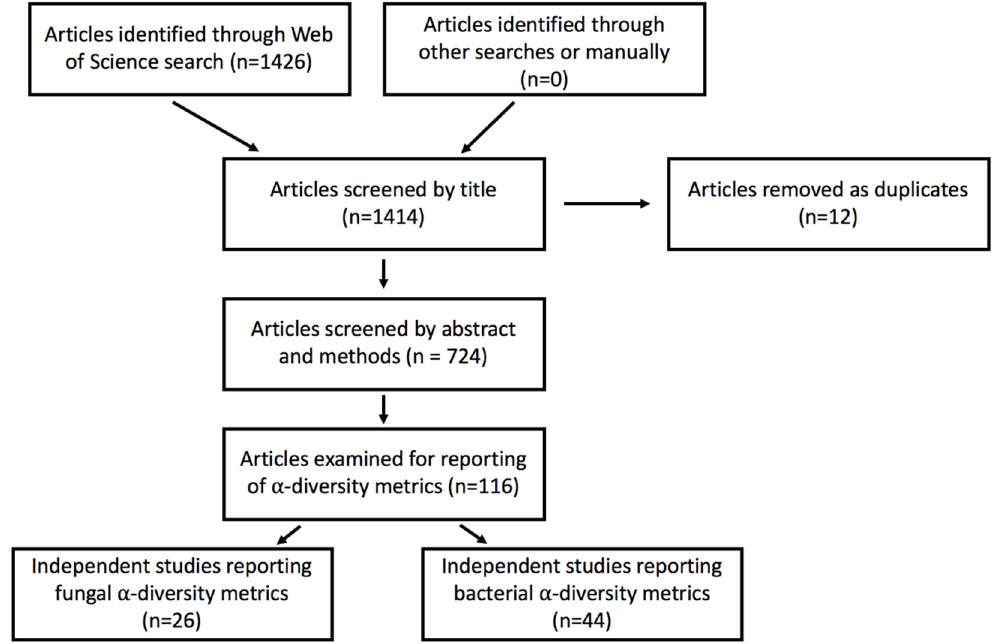
Figure 1. Flow diagram for studies retained through each filtering step. Final boxes represent the number of independent studies used for our meta-analysis.